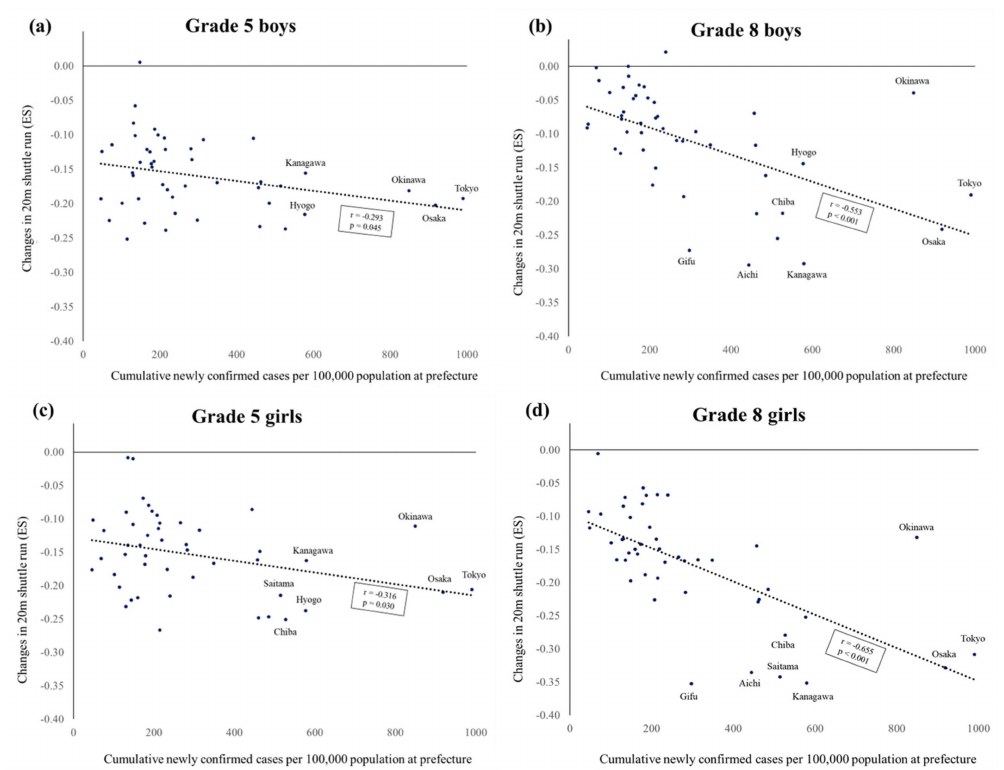
Figure 5. Changes in variability of CRF at prefecture levels between 2019 and 2021.